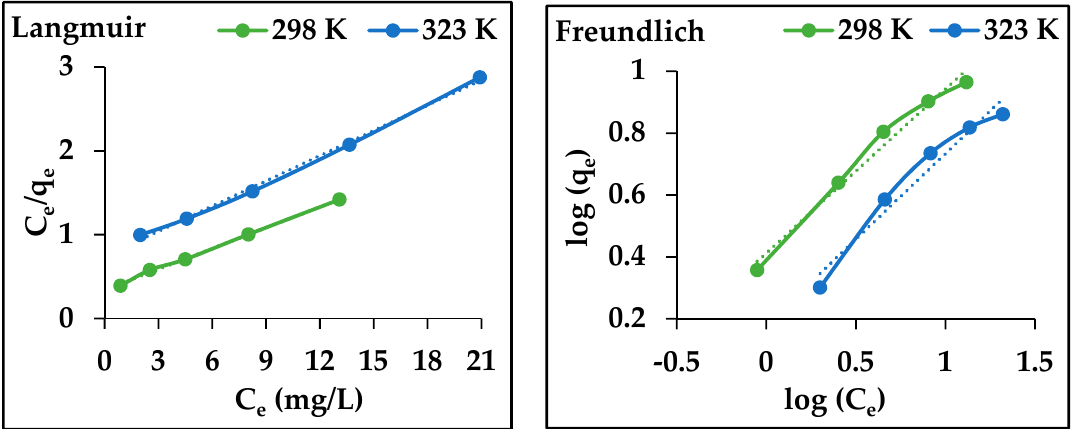
Figure 8. The adsorption isotherm model plots (Langmuir and Freundlich) for the adsorption of Cu 2 + on AgNPs (adsorbent dosage, 0.2 g; concentration of Cu 2 + , 10 and 50 mg / L; pH 7; contact time 3 h, at 298 K).